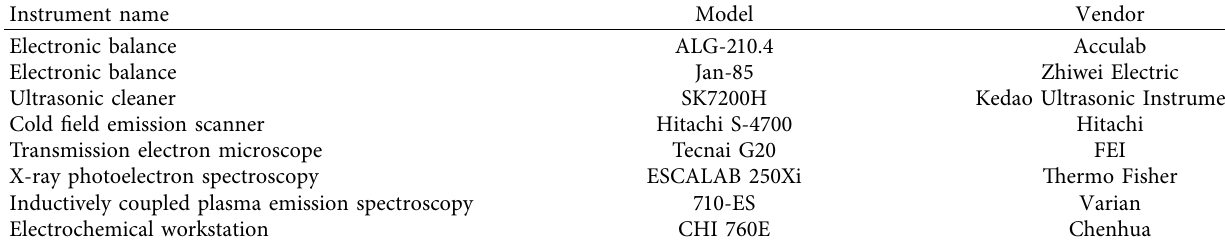
Table 2: Instrument name